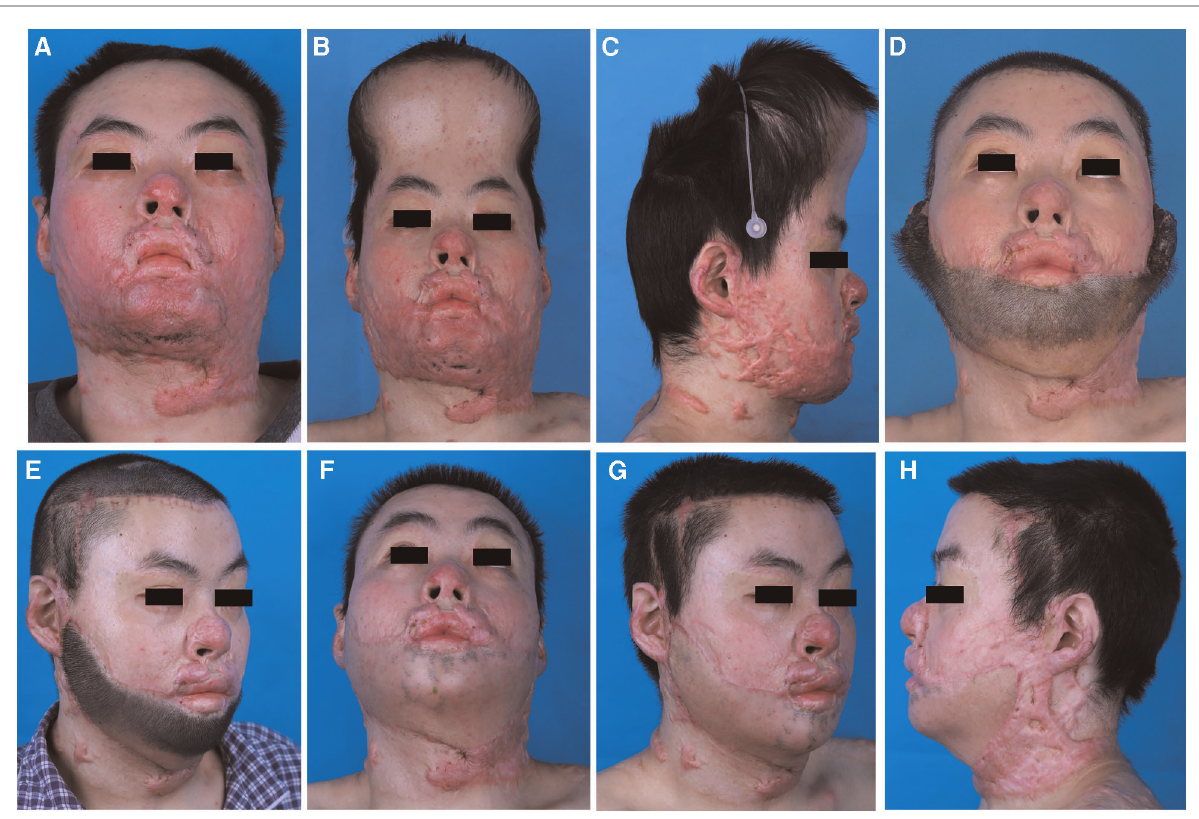
FIGURE 4 Case 3 ( A ), a 20-year-old man with severe post-burn scars in his lips and chin. ( B,C ), an 800 ml expander was implanted under the scalp. After two months, the fi nal expansion volume was 1090 ml. ( D ), the expanded scalp fl ap based on bilateral super fi cial temporal vessels was transferred to repair lower lip and chin. ( E ), postoperative view of 10 days after pedicle division. ( F – H ), the results at 5 months post-surgery after 2 sessions of laser hair removal treatment were aesthetically